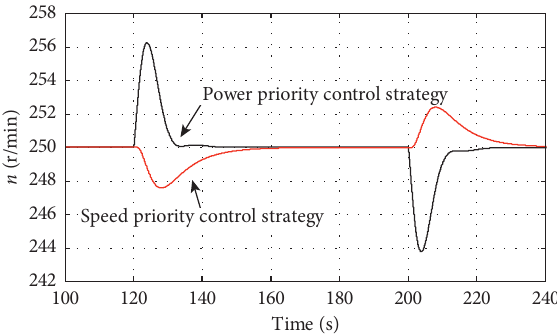
Figure 31: Speed comparison diagram when n